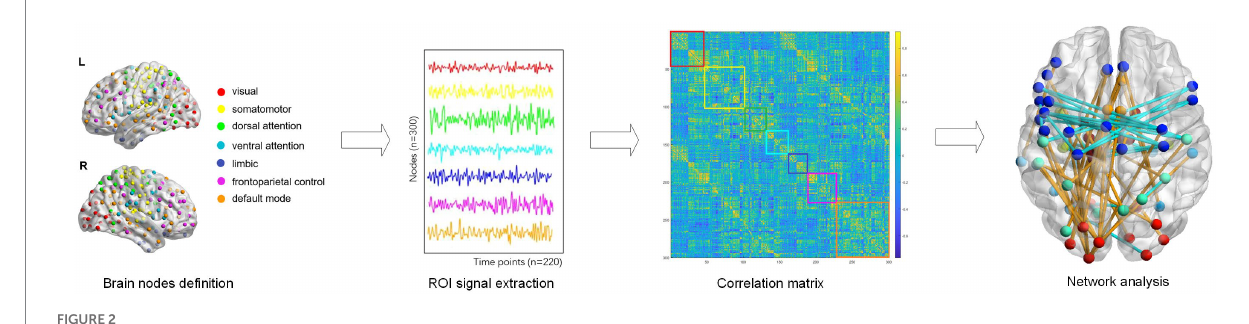
FIGURE 2 Functional network construction and graph